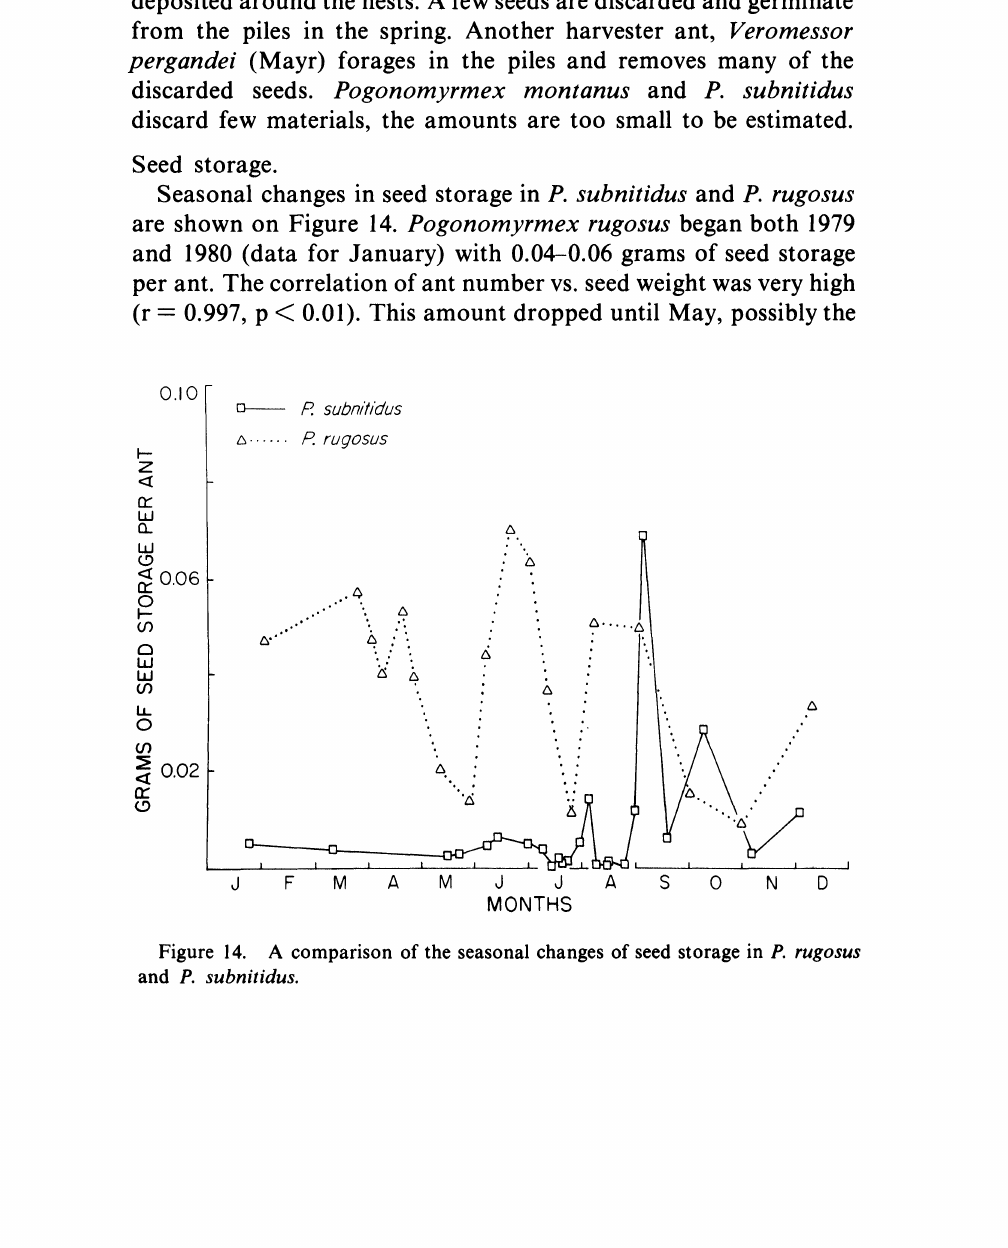
Figure 14. A comparison of the seasonal changes of seed storage in P. rugosus and P.